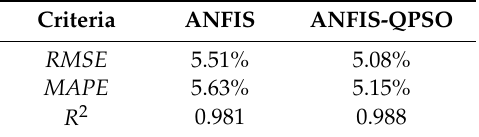
Table 10. ANFIS vs. ANFIS-QPSO performance comparison for the cryogenic turning